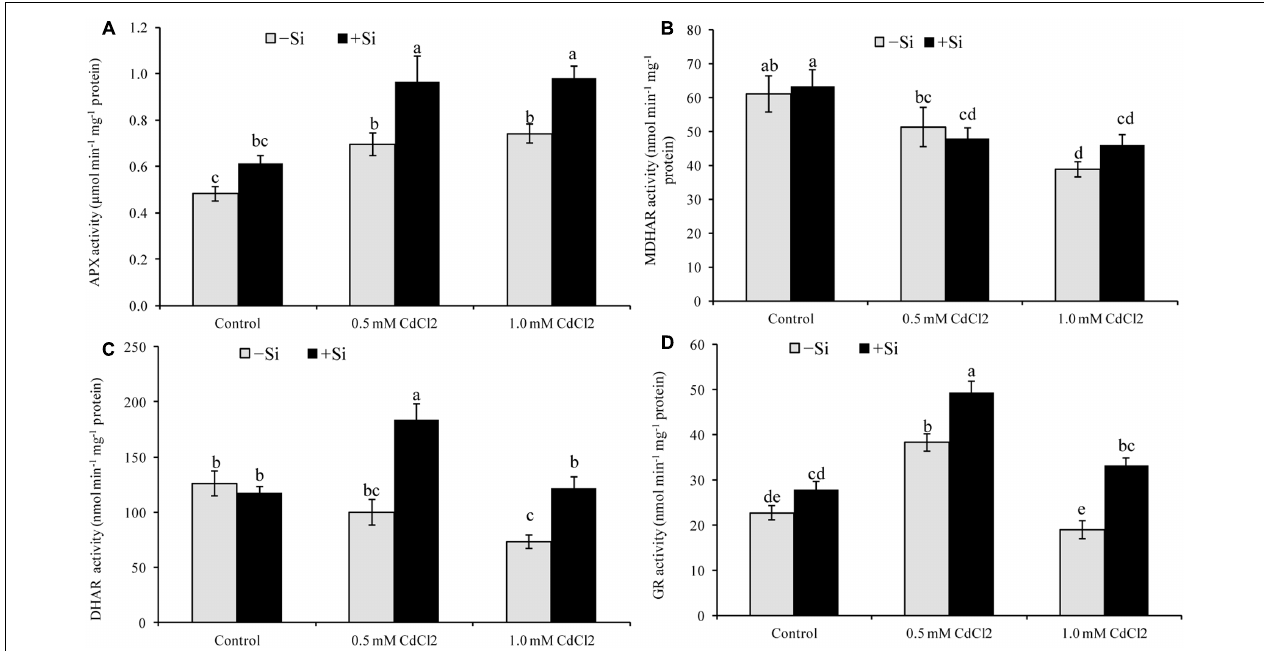
FIGURE 4 | Silicon-induced changes in the activities of AsA-GSH cycle enzymes (APX, MDHAR, DHAR and GR presented in A–D , respectively) in Brassica napus seedlings grown under Cd stress. Values (Mean ± SD) of each treatment are obtained from three replications. Bars with different letters are significantly different at P < 0.05 applying Tukey’s HSD